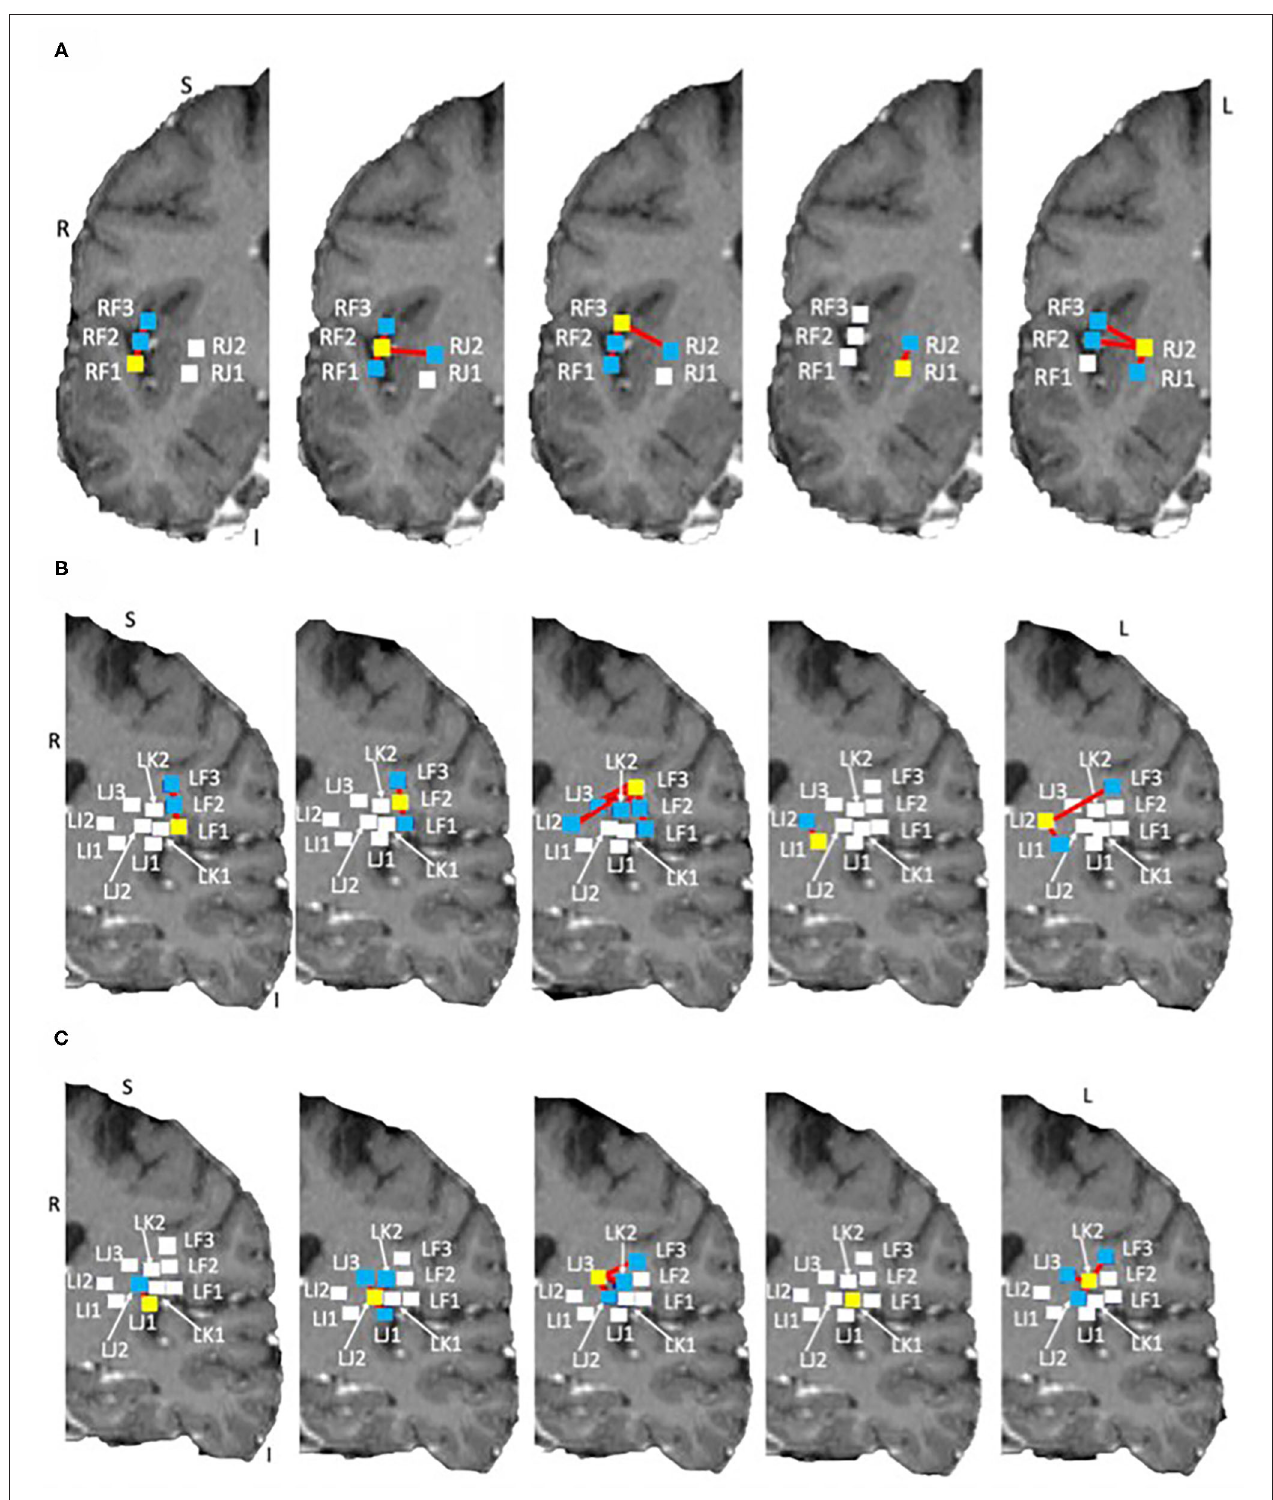
FIGURE 6 | Structural networks in the right and left hemispheres overlaid on the subject own T1 in DTI space. Shown on coronal slices. The electrode of interest is denoted by a yellow square in each image. Connections to other electrodes are shown by red lines and blue squares. Electrodes with no connections are shown by white squares. (A) Right side networks, (B,C) Left side networks. Note: no connections exist for LK1, electrode shown for completeness.